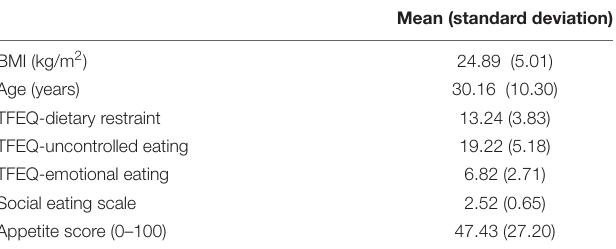
TABLE 1 | Participant characteristics Study